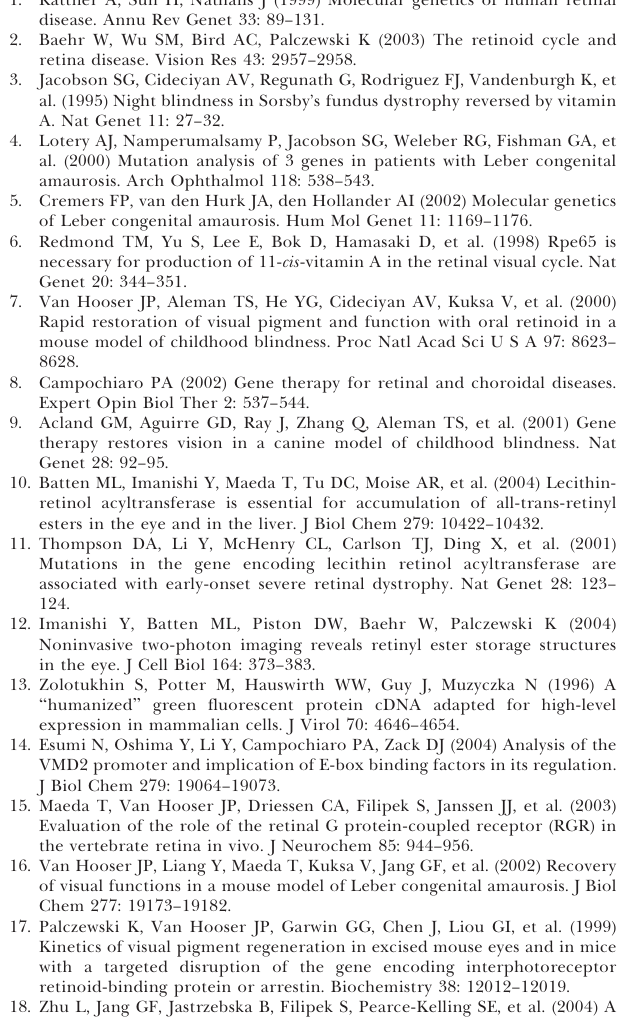
Figure S4. Scatter Plot of a- and b-waves of ERGs Obtained from rAAV- Lrat -Treated and Control Lrat (cid:2) / (cid:2) Mice (A) ERG a-waves of 6- to 7-wk-old Lrat (cid:2) / (cid:2) control mice. (B) ERG b-waves of 6- to 7- wk-old Lrat (cid:2) / (cid:2) control mice. (C) ERG a-waves of 6- to 7- wk-old rAAV- Lrat -treated mice. (D) ERG b-waves of 6- to 7- wk-old rAAV- Lrat -treated mice ( n (cid:4) 39). Found at DOI: 10.1371/journal.pmed.0020333.sg004 (129 KB PDF). Video S1. Effect of 9- cis -R-Ac Treatment on the PLR of Lrat (cid:2) / (cid:2) Mice PLRs of an individual Lrat (cid:2) / (cid:2) mouse (left eye) recorded prior (control) and 72 h subsequent (9- cis -R-Ac) to three 5- l mol doses of 9- cis -R-Ac. Presence of light stimulus (30-s pulse of narrow bandpass 470 nm light, 1.38 3 10 14 photons (cid:3) cm (cid:2) 2 (cid:3) sec (cid:2) 1 ) is represented in the movie by